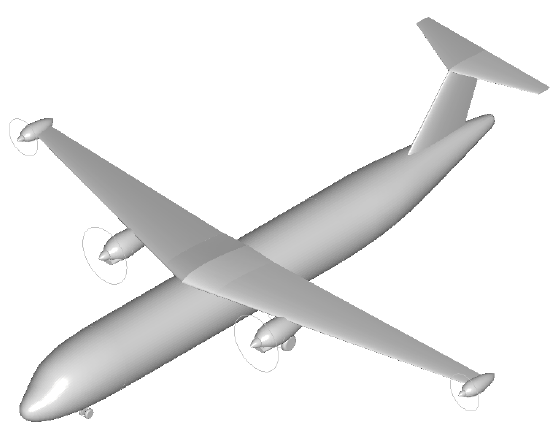
Figure 4. Aircraft design for S P =